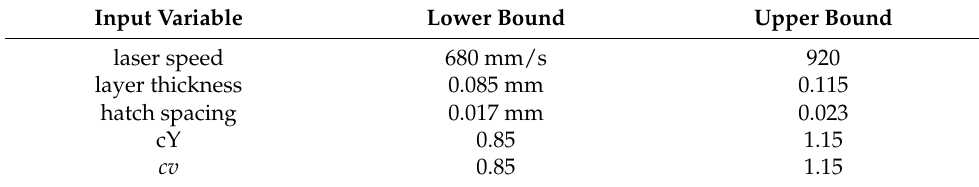
Figure 18. Uncertainty quantification along the three sides of the AMB2018-01 bridge structure. ( a ) represents the results along the length of the bridge, ( b ) indicates the results along the width of the bridge, and ( c ) shows the results along the height of the bridge. Table 5. Lower and upper bound for the input